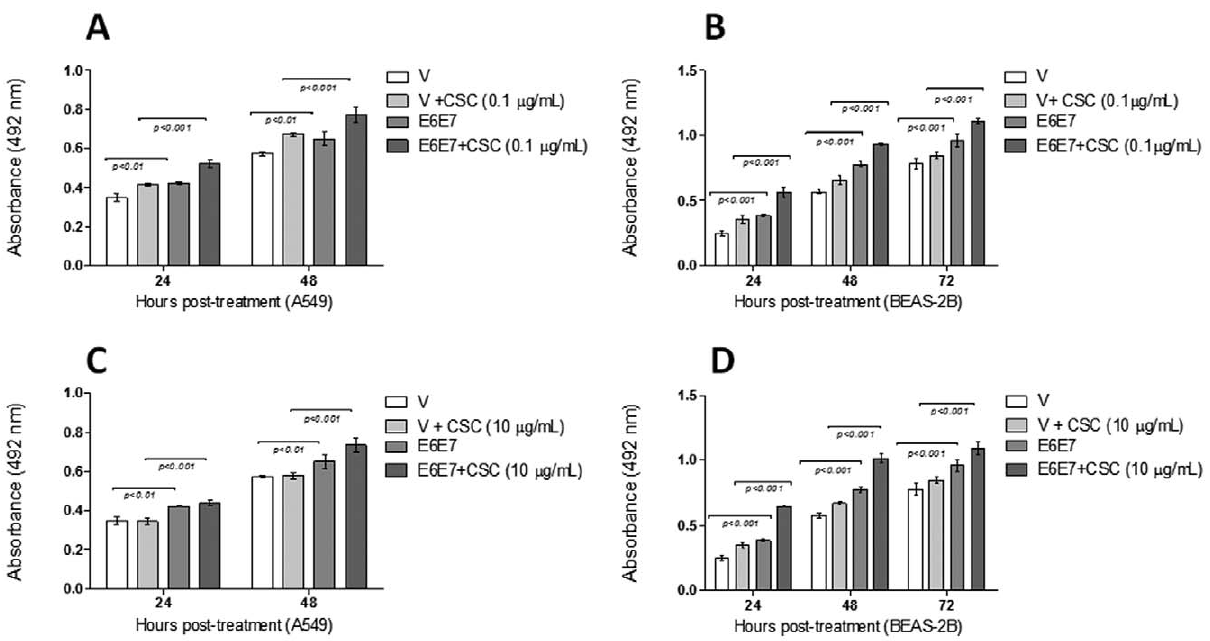
Figure 6. A549 (A, C) and BEAS-SB (B, D) cells transfected with pLXSNE6E7 constructs and exposed to 0.1 and 10 m g/mL CSC show an increased viability and proliferation rate (mean 6 SD, * p , 0.05; ** p , 0.01, *** p , 0.001, unpaired two-tailed Student’s t-test).